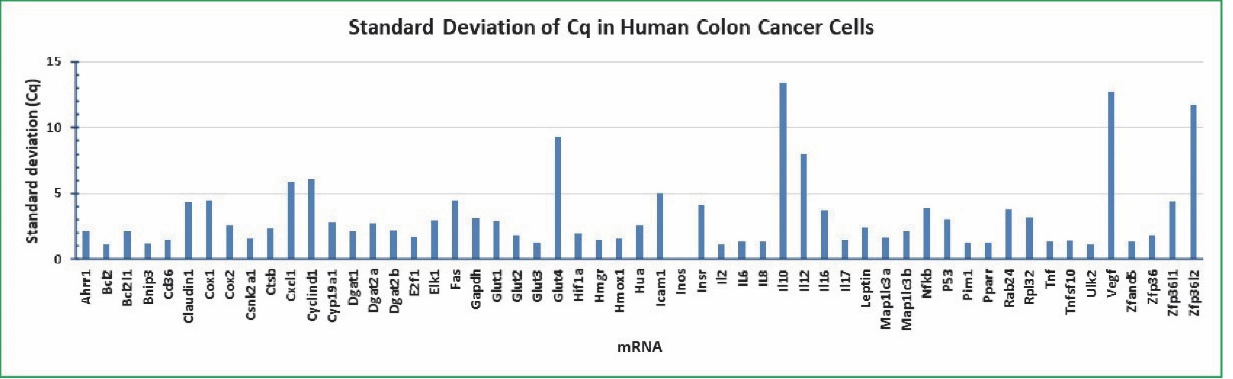
Figure 3. Mean standard deviation distribution of 55 mRNAs in human colon cancer cells. The cancer cells were treated with multiple concentrations of gossypol (0, 0.1, 0.5, 1, 5, 10, 50, and 100 µg/mL), LPS (0, 5, 10, 20, 50, 100, 500, and 1000 ng/mL) and cottonseed extracts (0, 5, 10, 20, 30, 40, 50, and 100 µ g/mL) for 8 h and 24 h. Total mRNAs were extracted from the cells, converted into cDNAs, and the relative abundance was analyzed by SYBR Green qPCR. The standard deviations of Cq values represent the mean of 192 independent